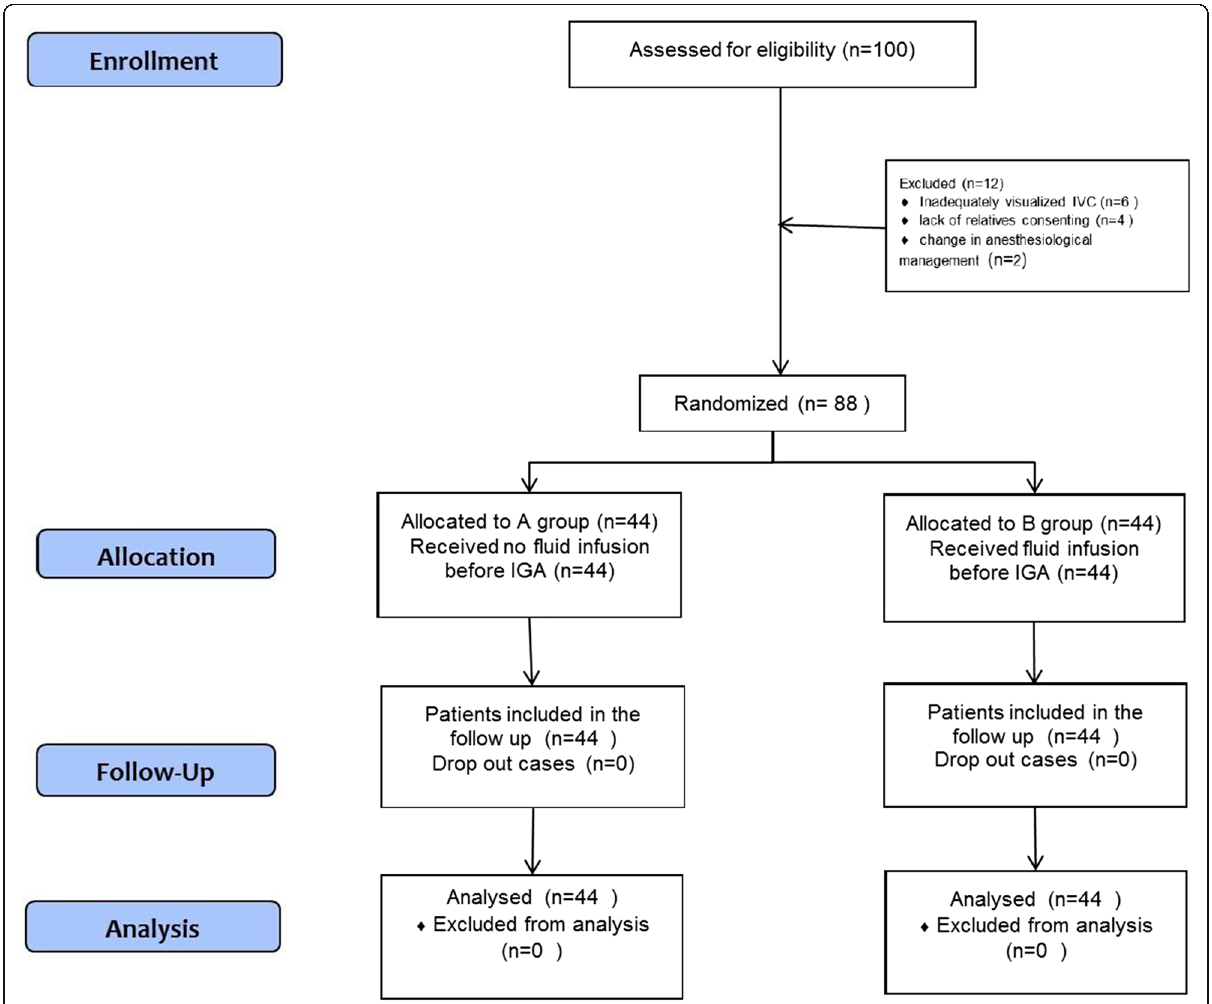
Fig. 1 CONSORT flow chart of the study